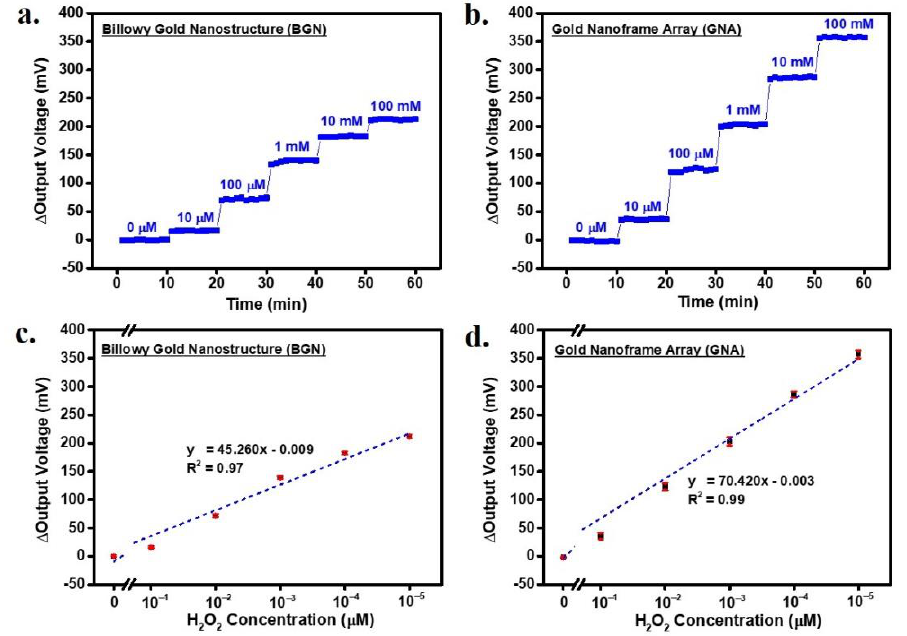
Figure 6. Real-time measurement of H 2 O 2 solution and the respective calibration plots performed by a portable CVCC circuit using the ( a ) and ( c ). billowy gold nanostructure (BGN) and ( b ) and ( d ). gold nanoframe array (GNA) electrodes.